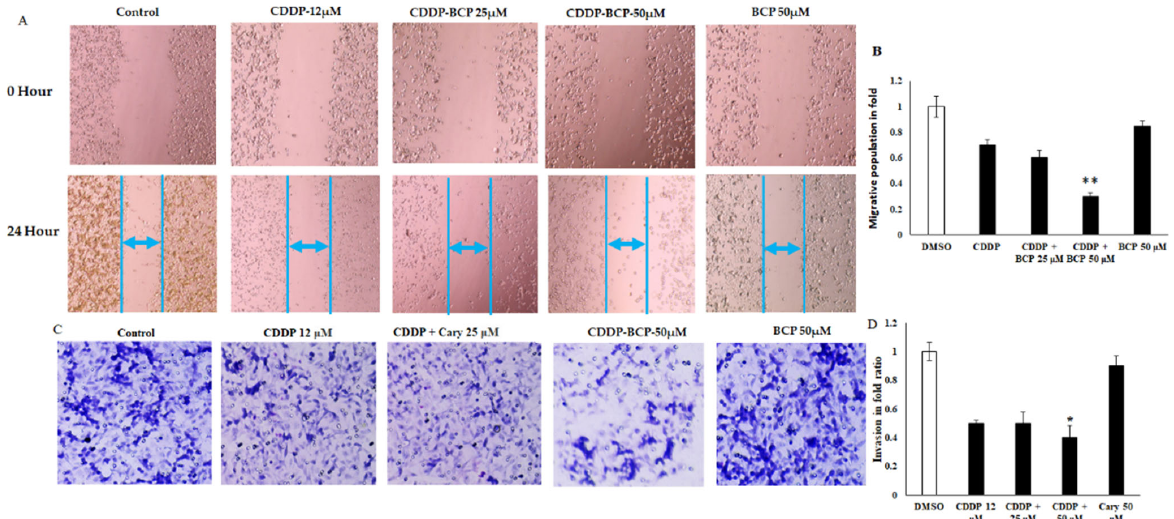
Figure 2. Beta-Caryophyllene reduces tumorigenic properties of A549 lung cancer cells. CDDP and BCP (12 and 25 μ M) alone or in combination evaded the migration and invasion of A549 lung cancer cells ( A , B ). The migrated cells population from different treated cell lines were quantified at a fixed area. ( C ) The invaded cells were stained with Giemsa and counted in four different microscopic fields ( D ). Invaded cells were quantified using manual counting. Values shown are mean ± SD for three independent experiments. * p < 0.05 compared to control vs. BCP alone. ** p < 0.01 significant difference. The invaded cells were calculated as the following; 50 cells = 1 fold, as in control and the treated cells value was 75 cells, so it was calculated as 1.5 fold. Values shown are mean ± SD for three independent experiments. * p < 0.05 and ** p < 0.01 significance and high significant differences, respectively, relative to CDDP-treated cells.